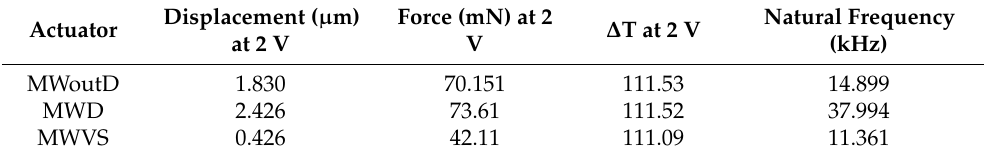
Table 10. Comparison of performance parameters of microgripper, obtained by simulation in AN- SYS.